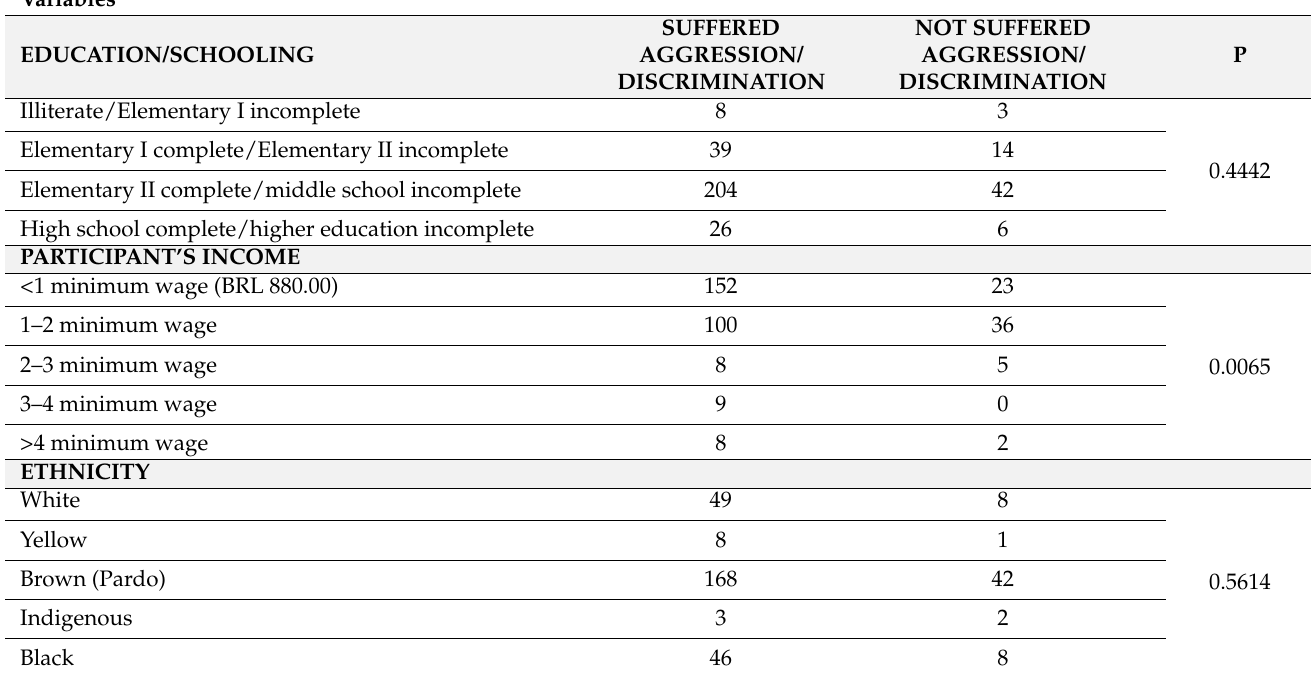
Table 4. Relationship of aggression/discrimination with ethnicity, education, and family income of men who have sex with men in Bel é m, Par á , Brazil,